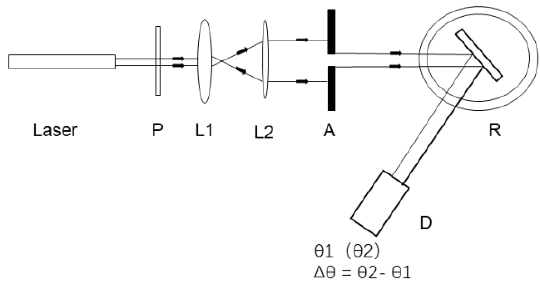
Figure 1. Schematic diagram of experimental device.